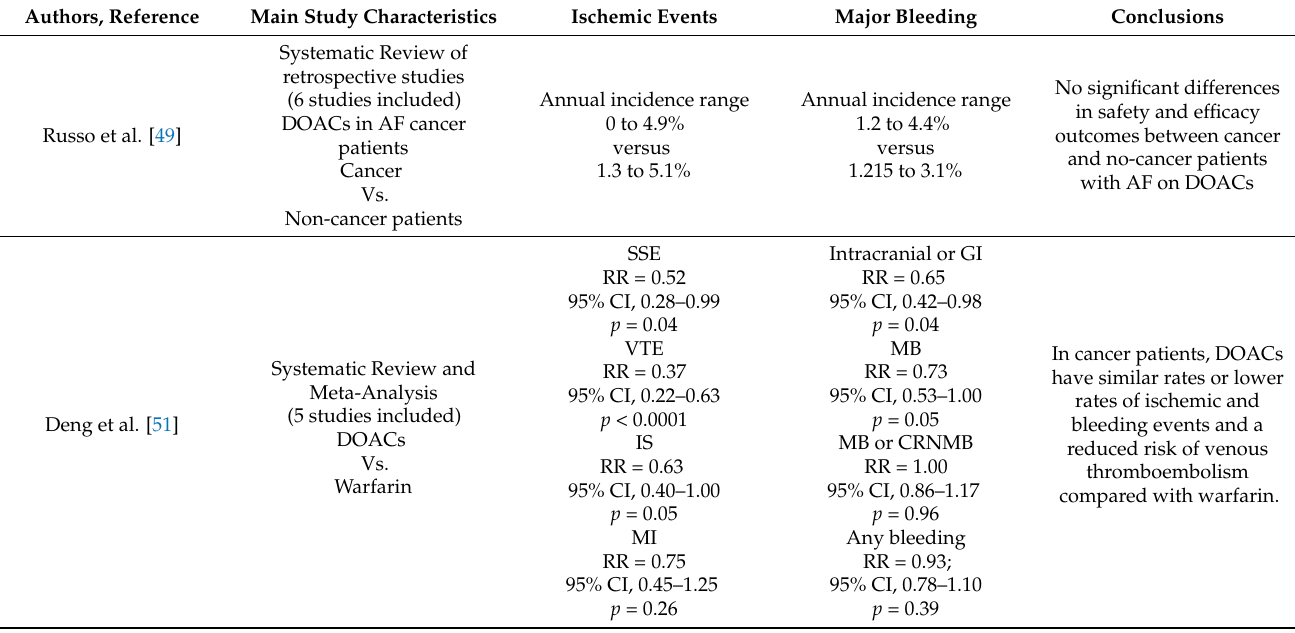
Table 2. Results of the main studies exploring the efficacy and safety of direct oral anticoagulants in cancer patients with atrial